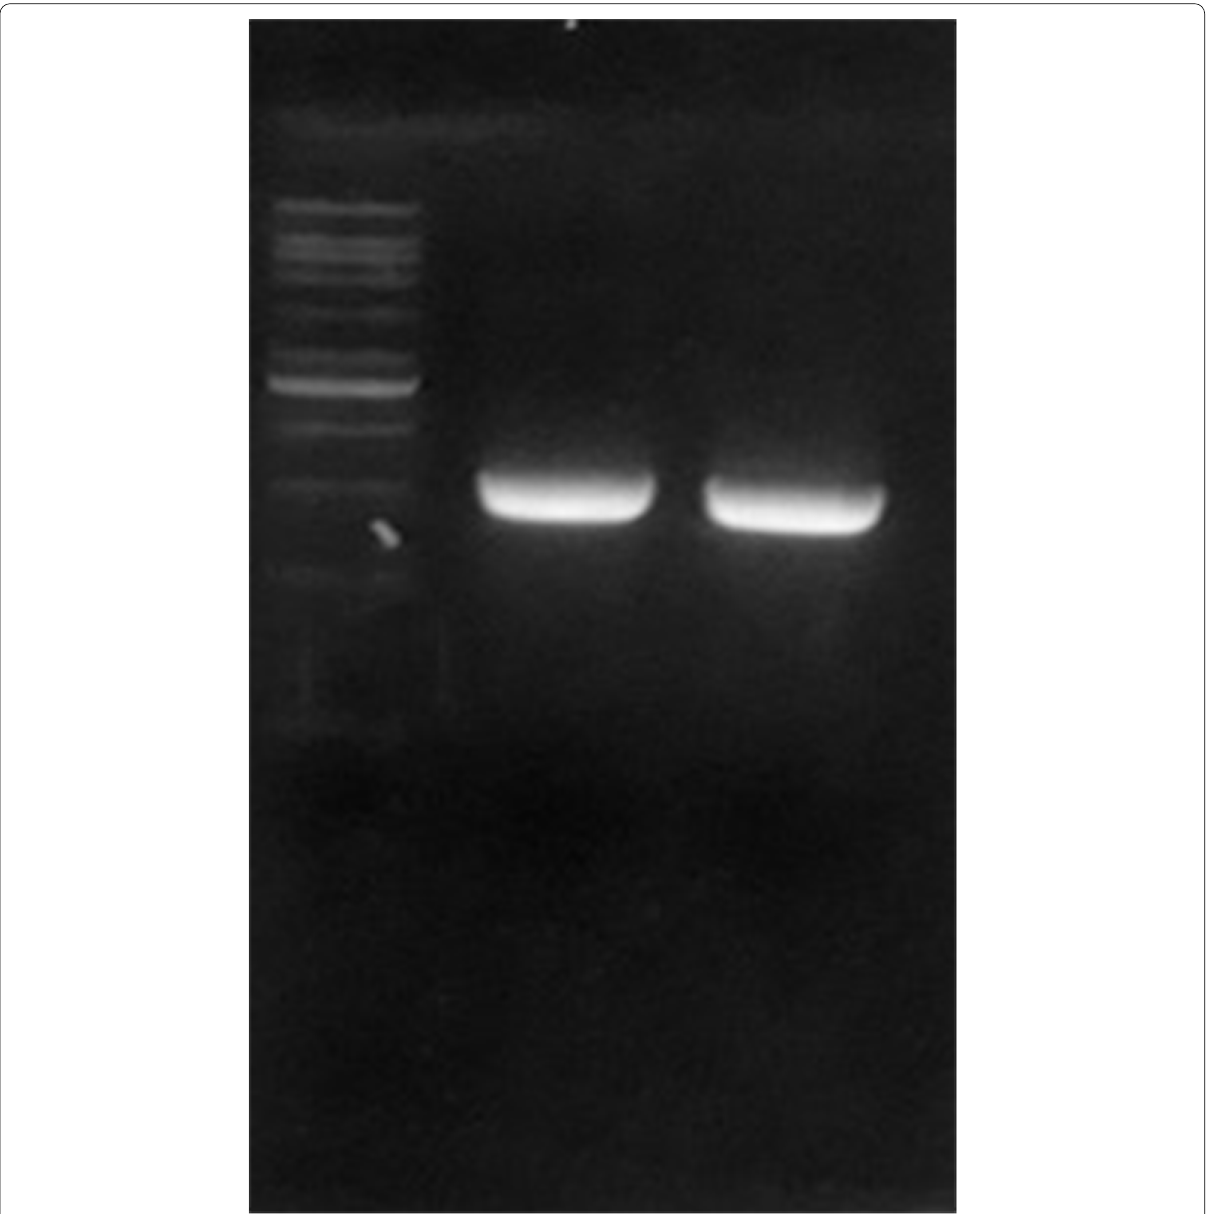
Fig. 3 Electrophoregram of positive transformant Colony number 9 harboring L1-HPV52, amplification was done using a specific primer with annealing temperature of 53°C resulting in clear DNA bands at 1473 bps. M: 1 kb DNA Ladder